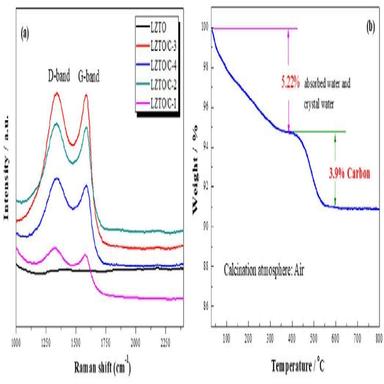
(a) Raman spectra of the pure LZTO, LZTO/C-1, LZTO/C-2, LZTO/C-3, and LZTO/C-4. (b) TG curve of LZTO/C-3 sample.